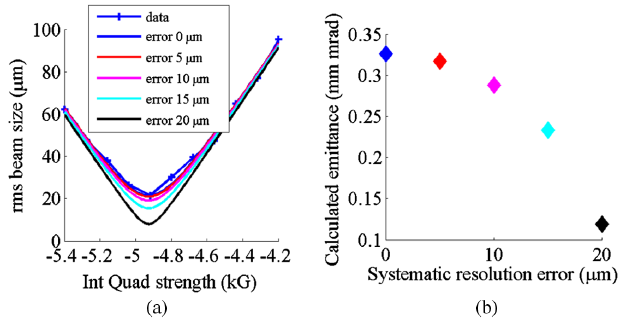
FIG. 28. Emittances computed from the 30 pC data as a function of the truncation level used in computing the rms bunch sizes. The Gaussian fit results are plotted at 0% truncation. The blue points are from the horizontal scans and the red points are from the vertical